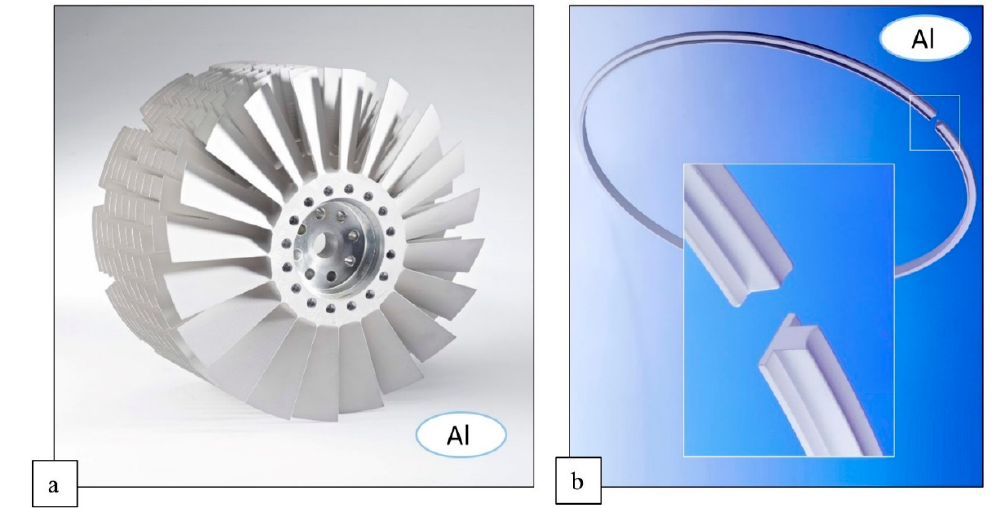
Figure 13. Application examples for PEO coatings (commercial name KEPLA-COAT ®® ) on Al-substrates: Rotor ( a ) and centering ring, ( b ) of turbomolecular pumps, coatings from Aalberts Surface Treatment GmbH [77].